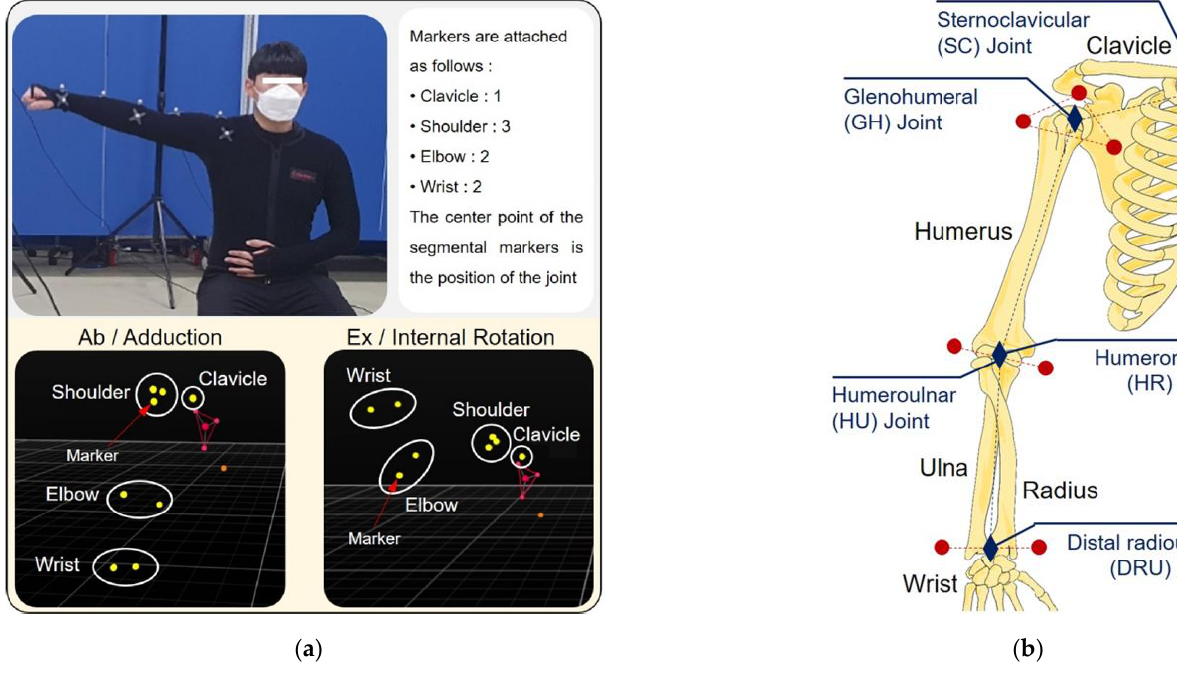
Figure 2. Photograph of the motion capture. ( a ) Abduction/adduction and external/internal rotation was performed to obtain the position and direction data of the markers. ( b ) The markers were attached to the skin to coincide with the central coordinate of the joint.